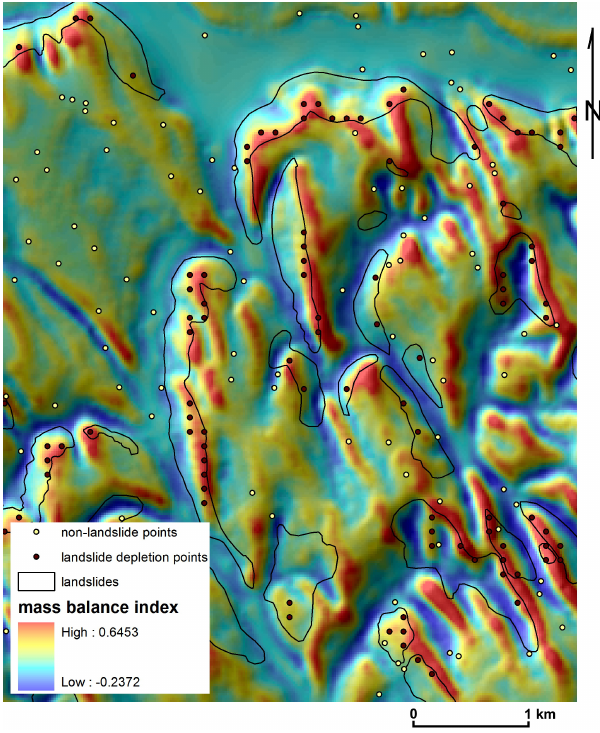
Fig. 6. The mass balance index used for sampling the landslide de- pletion areas (detail of the Lungani